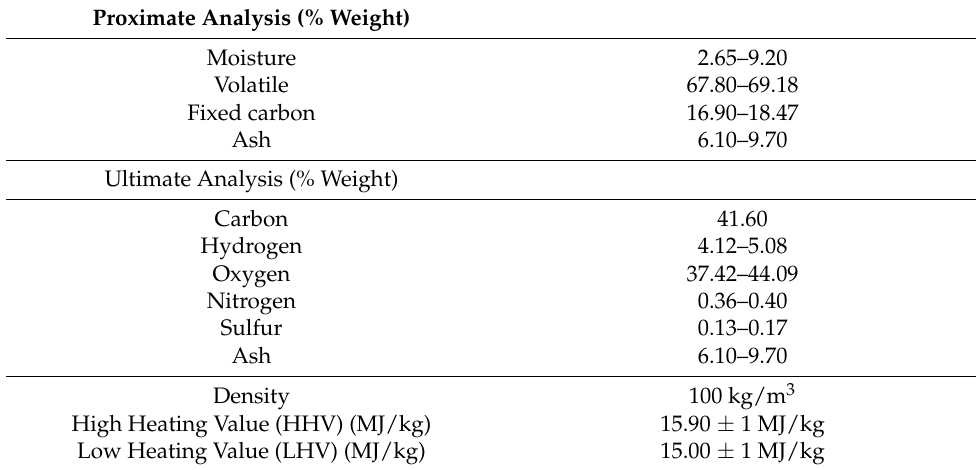
Table 1. Physicochemical properties of cane